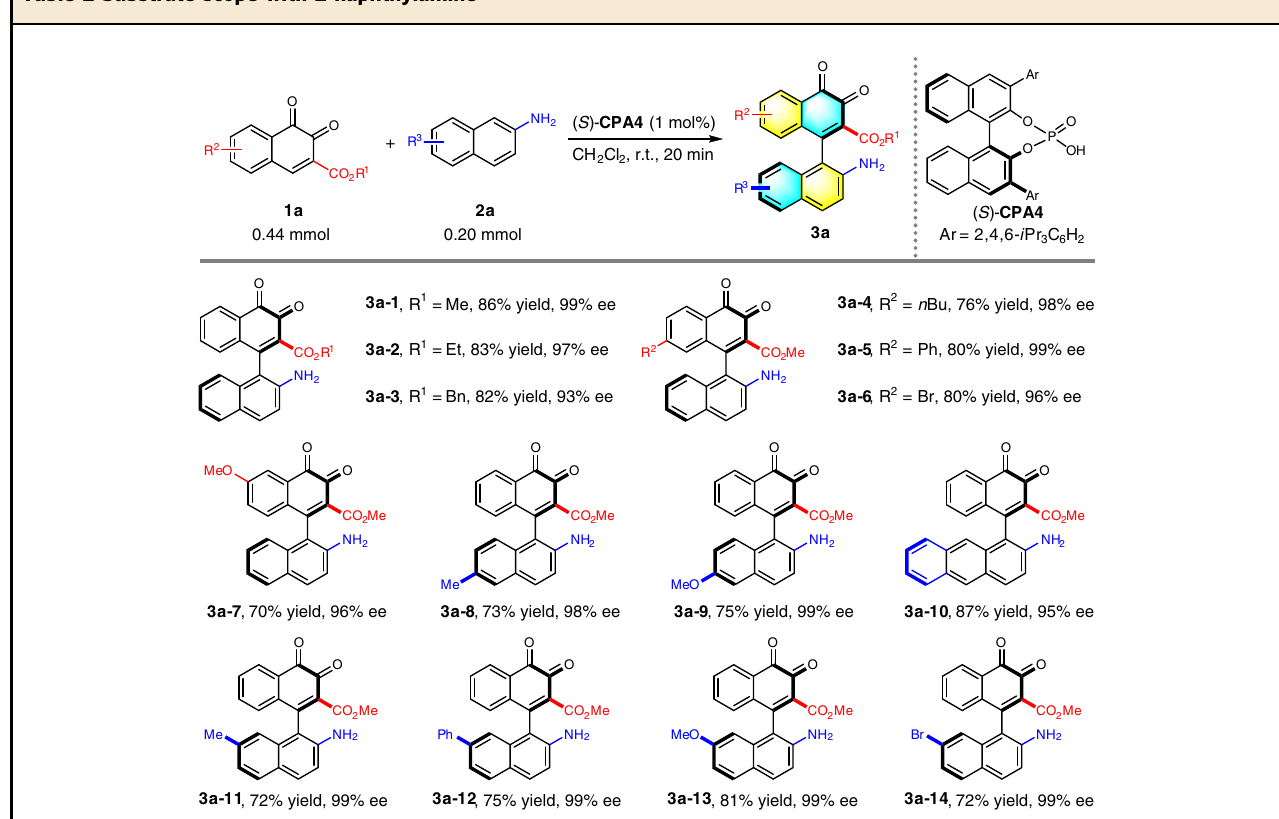
Table 2 Substrate scope with 2-naphthylamine